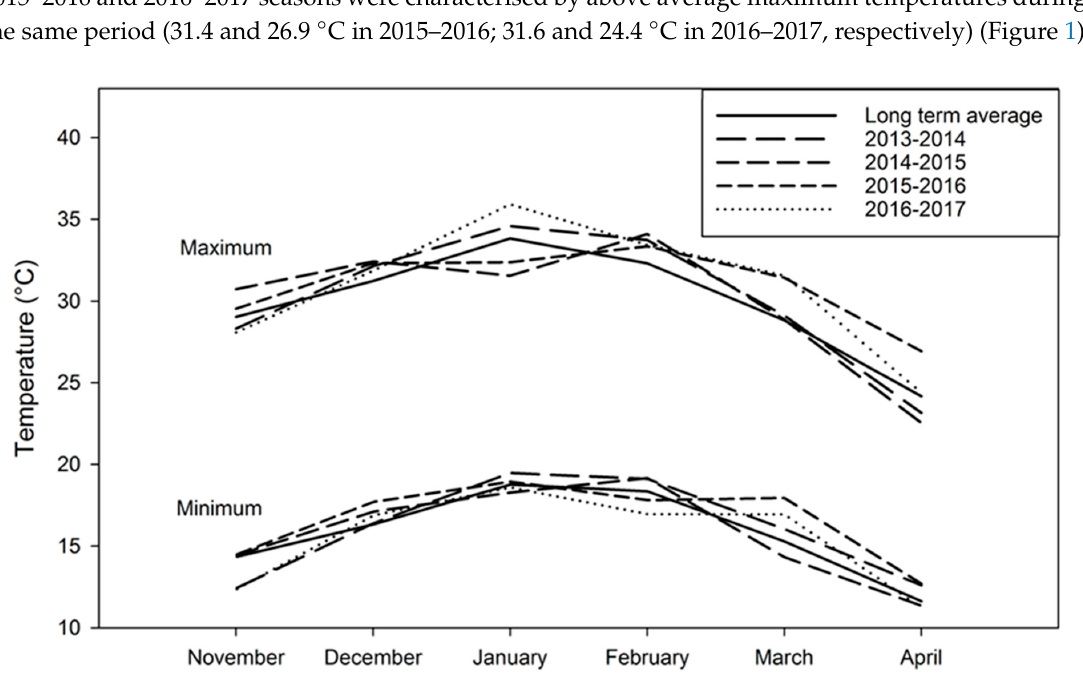
Figure 1. Average monthly minimum and maximum temperatures for each growing season and the long-term average [16] at Yanco Agricultural Institute (34.62° S, 146.43° E), 6 km east of the field site. Long-term average 1999–2016.